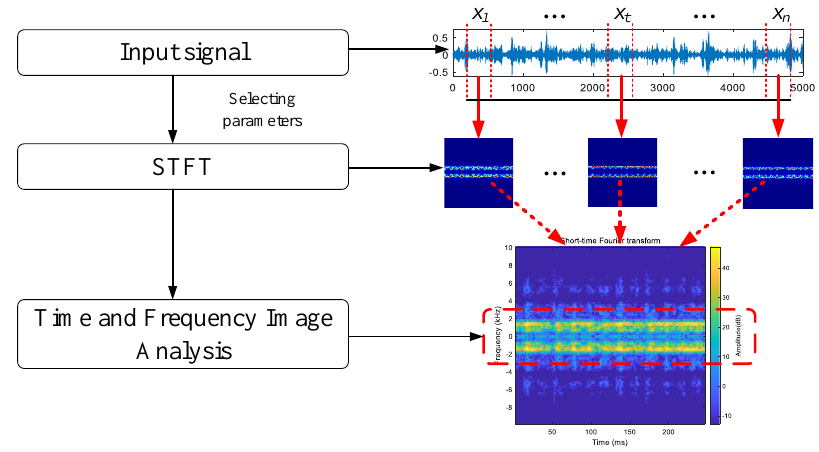
Figure 1. The schematic diagram of the basic principle of the STFT.